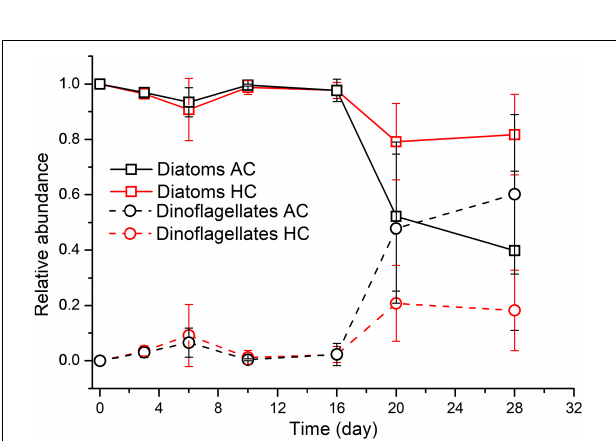
FIGURE 5 | Temporal variations of the relative abundance of diatoms and dinoflagellates in HC (1000 ppmv) and AC ( ∼ 410 ppmv) treatments. Data are means ± SD of replicates for HC treatments and for AC